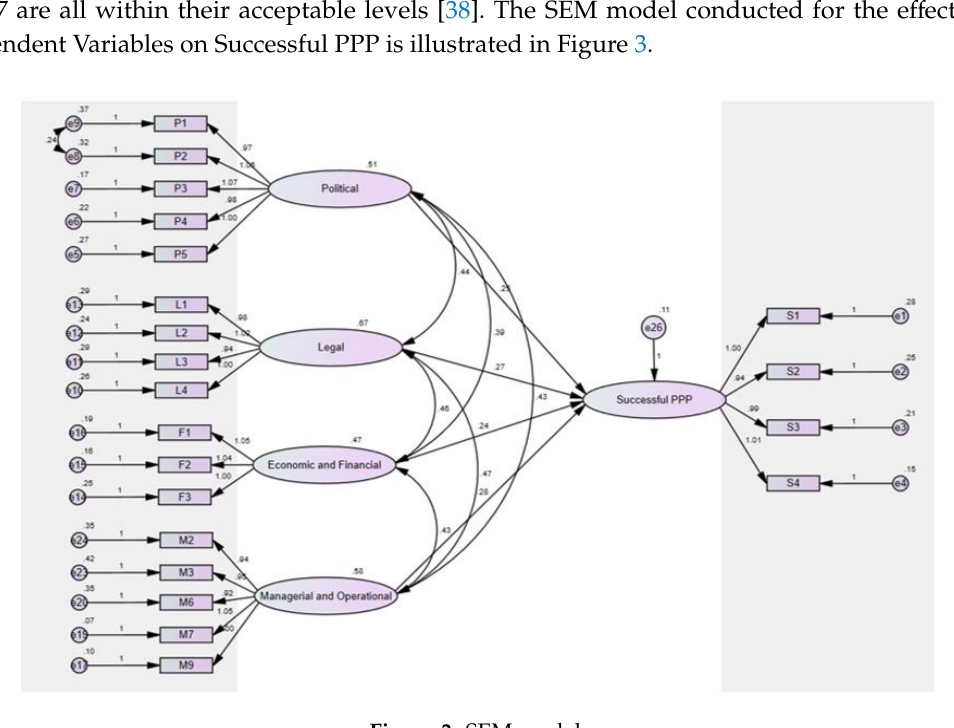
Table 11. Structural equation modeling (SEM) analysis of independent variables on successful PPPs. Dependent Variables Independent Variables Estimate p R 2 Successful PPP ← Political 0.255 0.006 0.826 Successful PPP ← Economic and Financial 0.244 0.045 Successful PPP ← Legal 0.271 0.001 Successful PPP Managerial and Operational 0.280 0.001